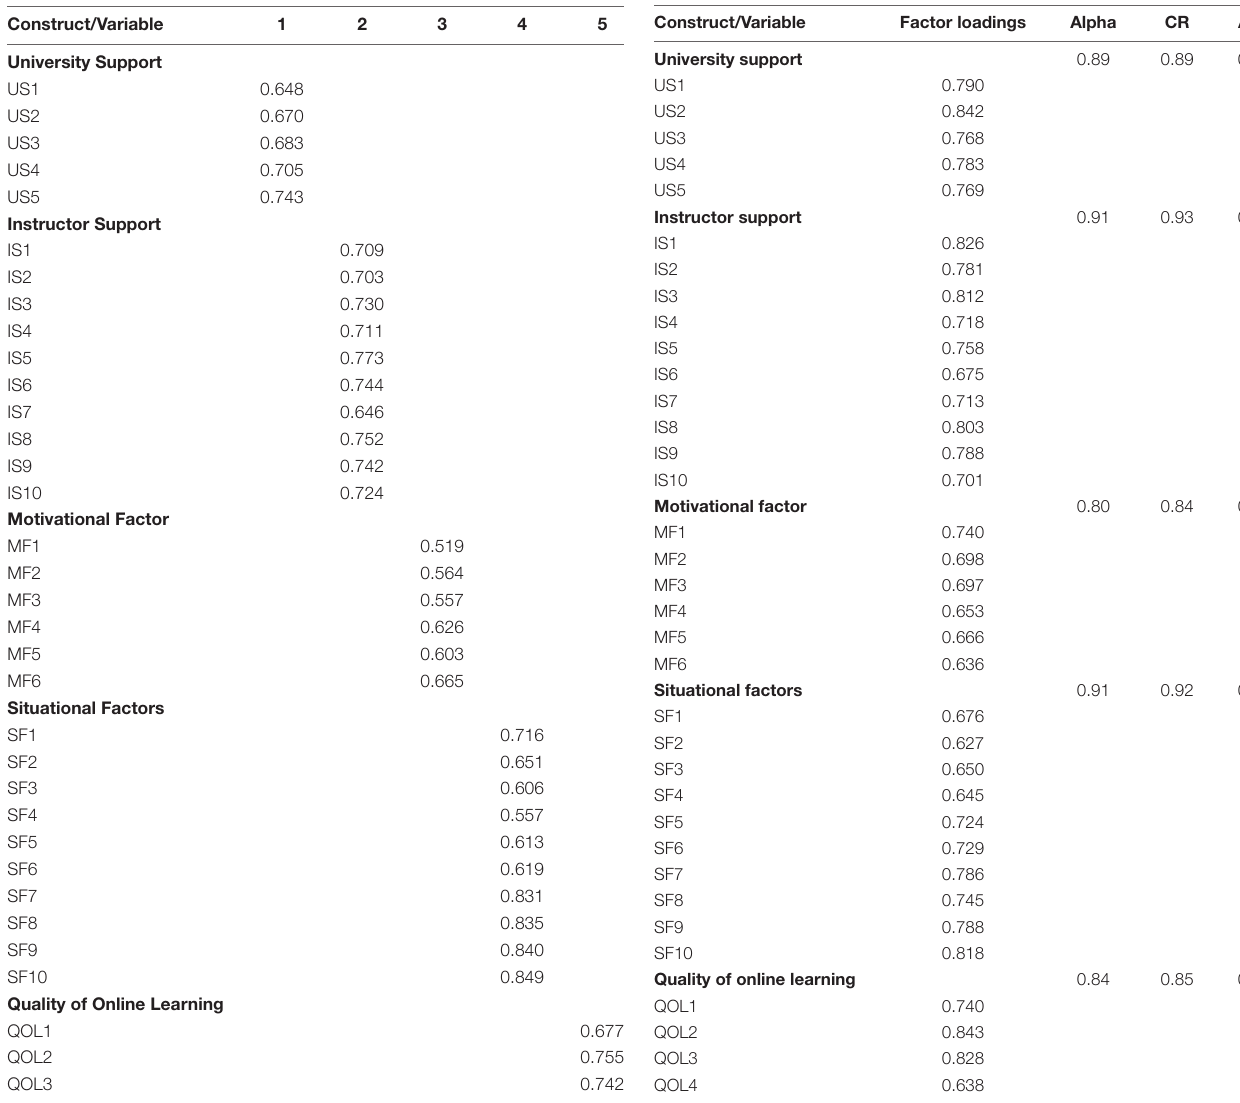
TABLE 1 | Results of exploratory factor analysis (EFA). TABLE 2 | Results of confirmatory factor analysis